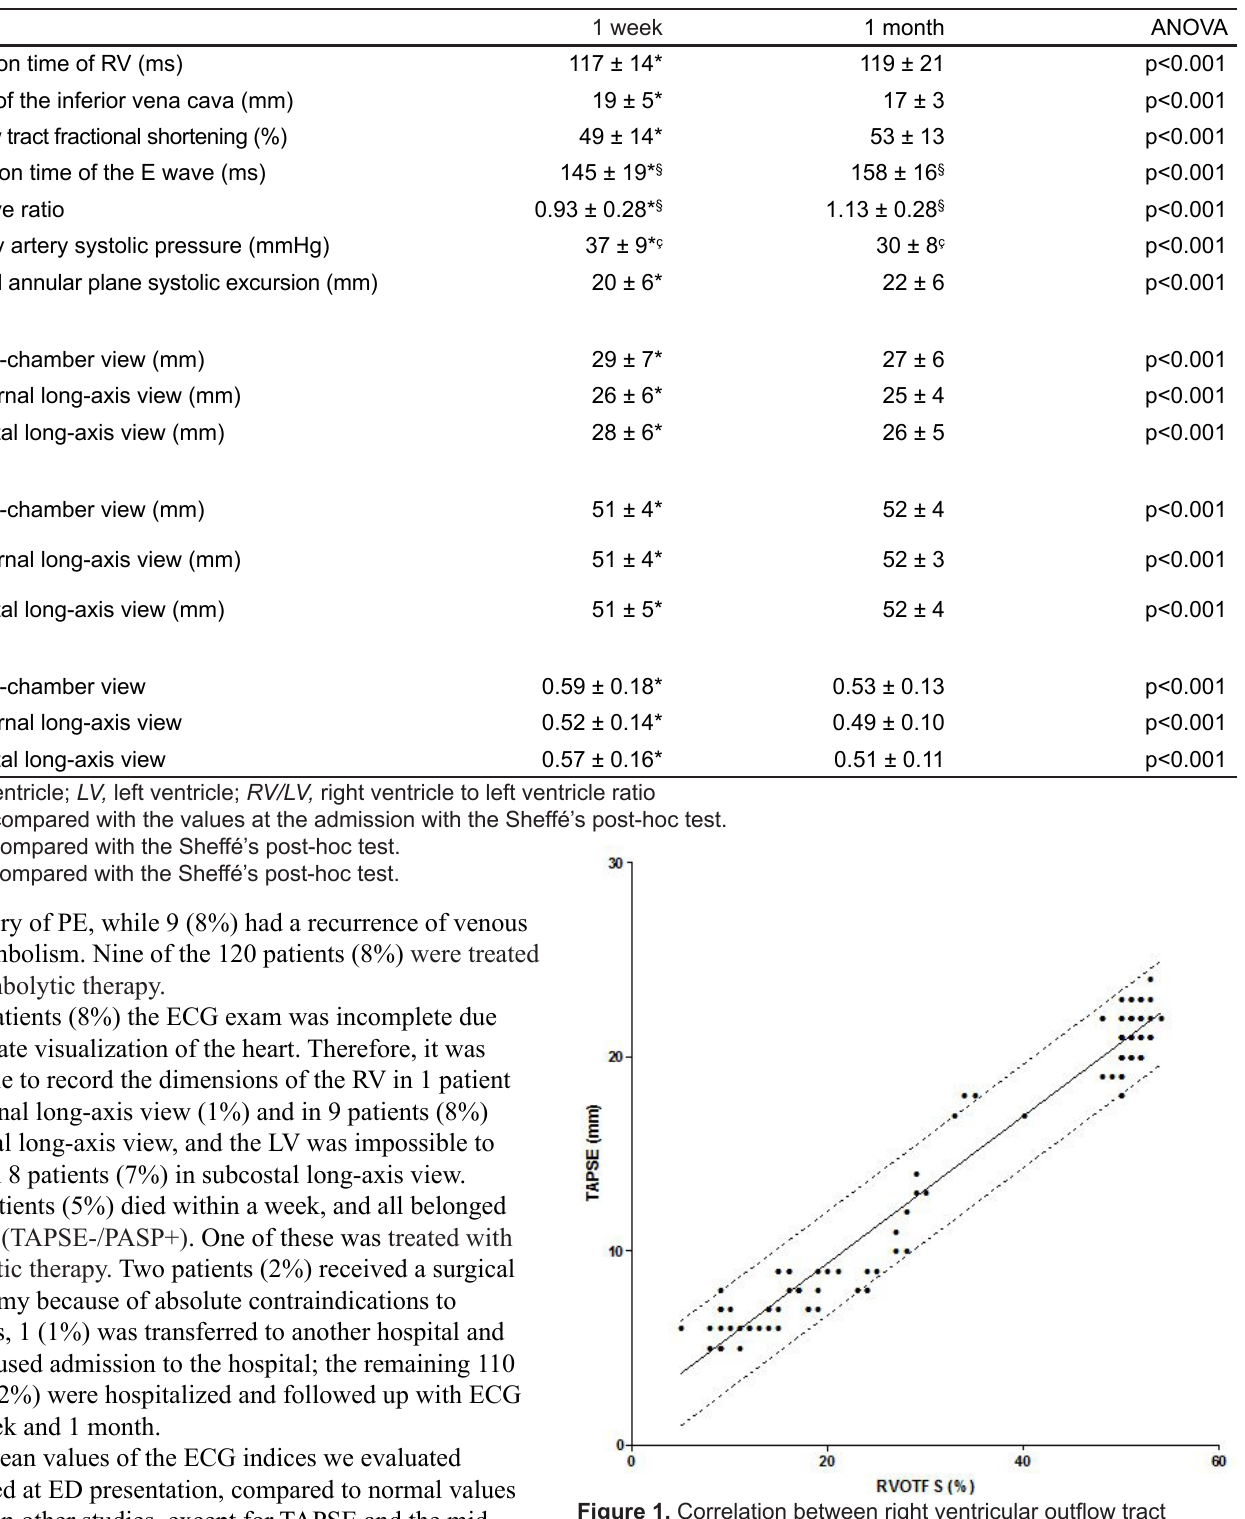
Figure 1. Correlation between right ventricular outflow tract fractional shortening (RVOTFS) and tricuspid annular plane systolic excursion (TAPSE) values of the right ventricle registered at the admission. The central continuous line indicates the regression line. The dashed lines indicates the standard error of estimates.